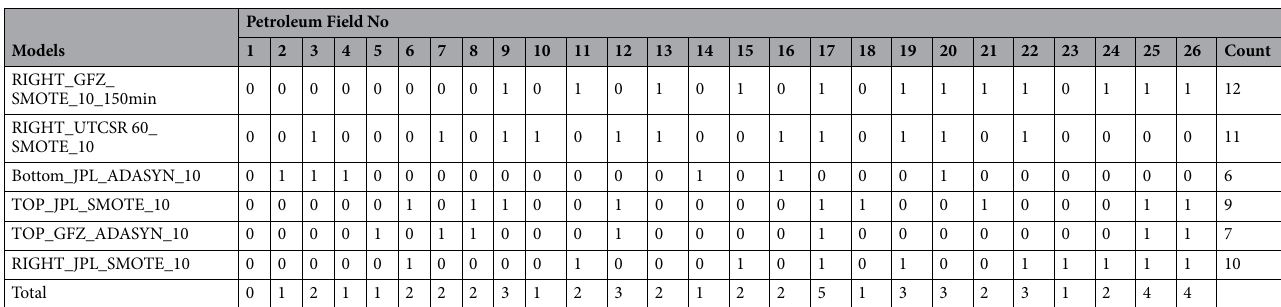
Table 5. Matrix with the minimum number of best-performing models that can detect the maximum number of deposits in the testing region using the models that can detect at least six of the existing petroleum deposits.